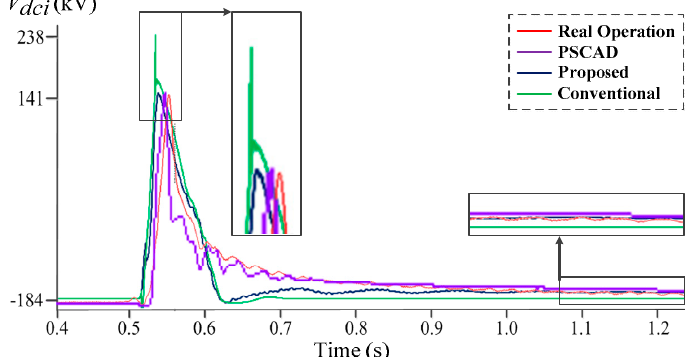
Figure 11. Inverter DC voltage for a single-phase line-to-ground fault.